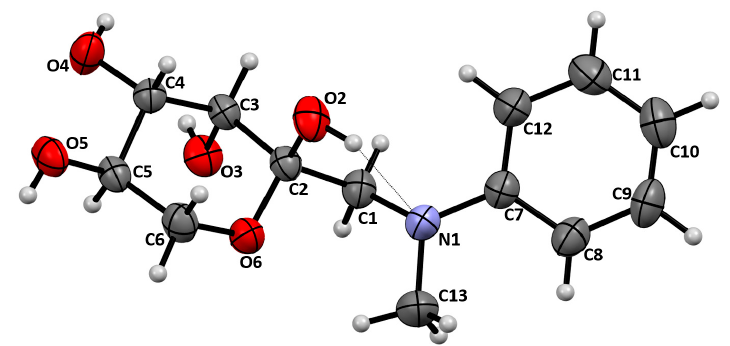
Figure 2. Atomic numbering and displacement ellipsoids at a 50% probability level for N -(1-deoxy- α - D -tagatopyranos-1-yl)- N -methylaniline. The intramolecular hydrogen bond is shown as a dotted line.